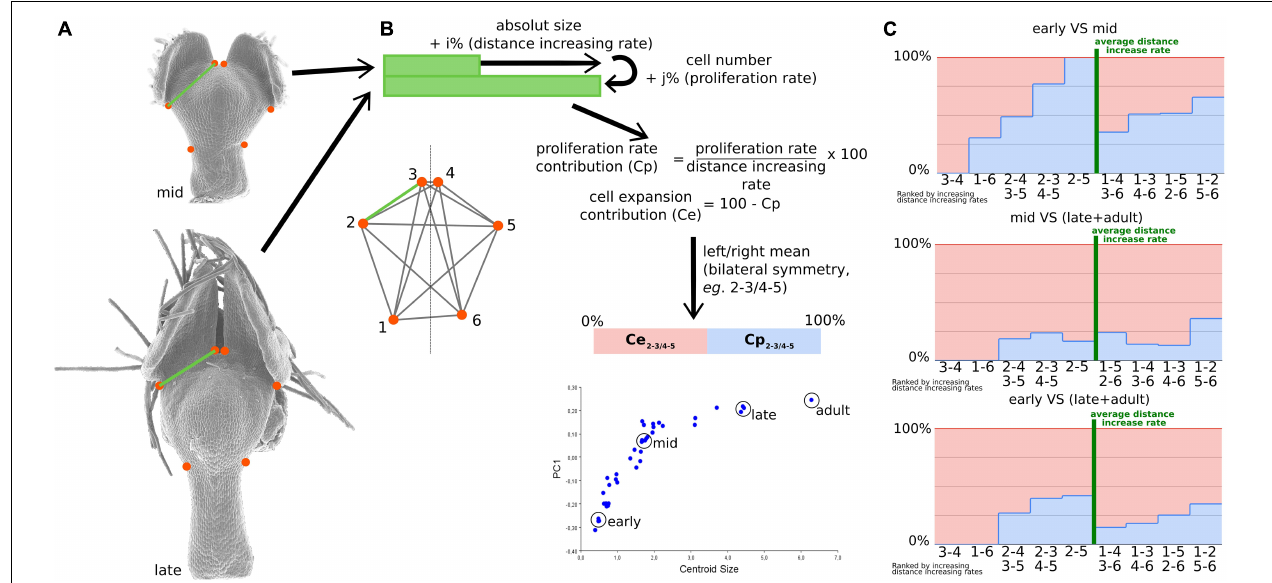
FIGURE 4 | The relative contribution of cell proliferation and cell expansion during nectar pouch development. Distances between every pair of landmarks recapitulate shape information as much as landmark coordinates (A) . The calculation of proliferation rate and cell expansion contributions to landmark inter-distance dynamics is presented (B) . Three triplets of petals corresponding to early, mid, and late stages and one adult petal have been used to study the contributions. For each individual, pairs of landmarks that are left-right symmetric have been averaged, and the measures of each triplet have also been averaged. The relative contributions of cell proliferation (light blue) and expansion (pink) are summarized in (C) . For each comparison (early to mid, mid to late, and early to late), landmarks have been ordered according to increasing inter-distance values between the two stages. Green bars correspond to the average rate of the increase in inter-landmark distance between consecutive stages.